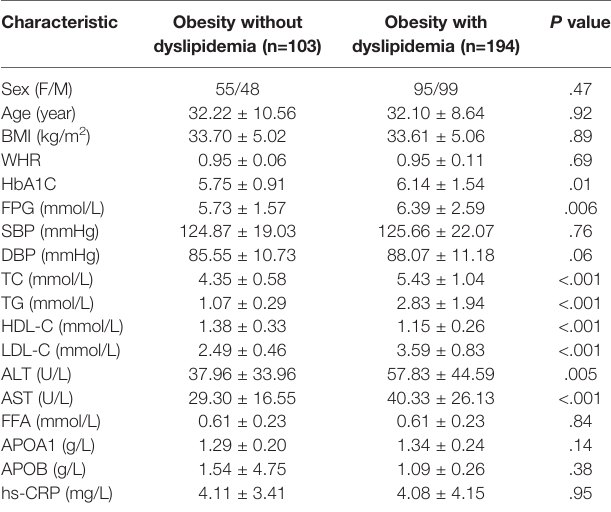
TABLE 1 | Clinical and biochemical characteristics of the studied